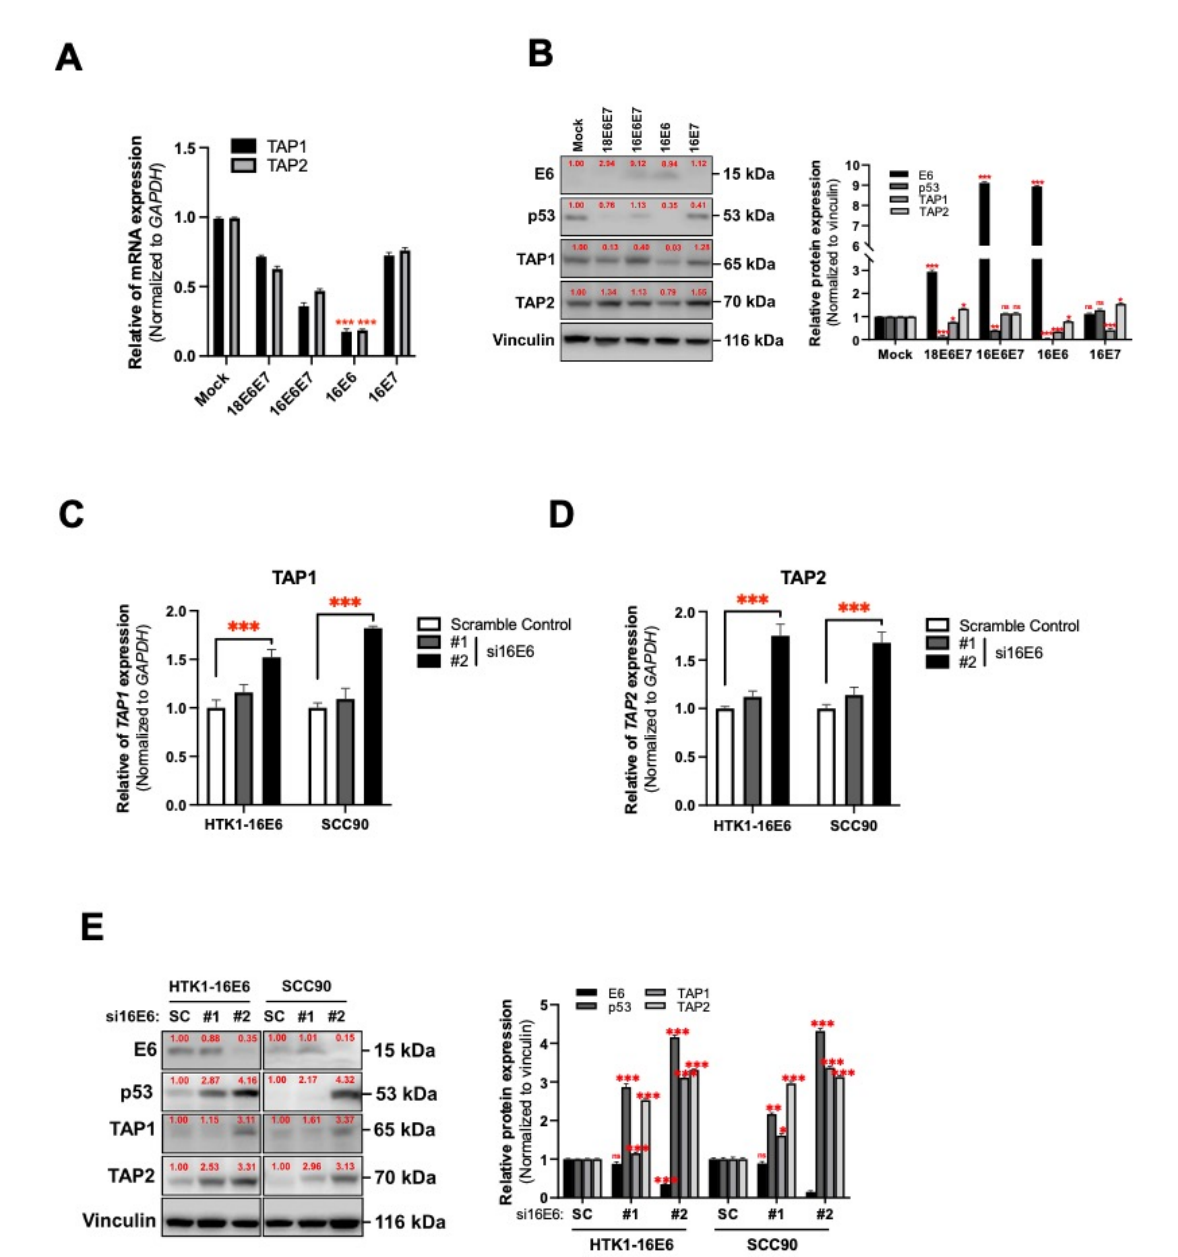
Figure 3. The E6 oncoprotein of HPV16 downregulates TAP1 and TAP2 expression in oral epithelial cells. ( A , B ) The expression of TAP1 and TAP2 mRNA and protein in HTK1-K4DT transduced with E6 and/or E7 from HPV16 or HPV18, assessed by qRT-PCR ( A ) and immunoblotting ( B ). ( C – E ) The expression of TAP1 and TAP2 mRNA and protein in HPV16 E6-expressing HTK1-K4DT transfected with siRNA-specific HPV16 E6, assessed by qRT-PCR (( C ) for TAP1 and ( D ) for TAP2) and immunoblotting ( E ). All experiments were carried out in triplicate, and at least three independent experiments were performed. SC, scramble control. Red numbers indicate the relative intensity of the protein band as determined using ImageJ software. * p ≤ 0.05; ** p ≤ 0.01; *** p ≤ 0.001; ns—not significant.